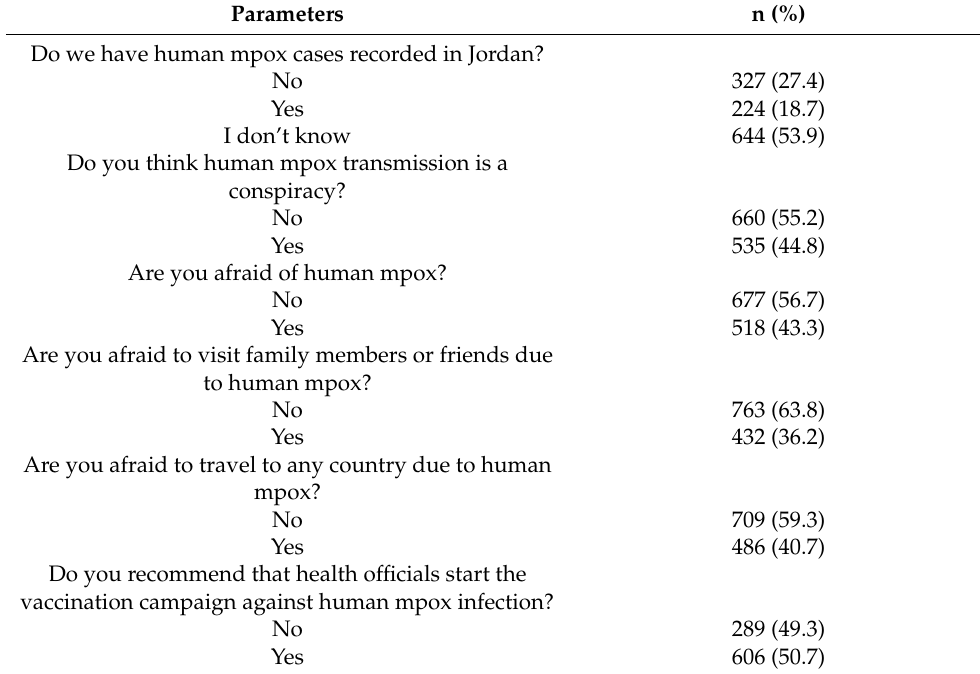
Table 2. Public awareness and level of fear of human mpox transmission (n = 1195).